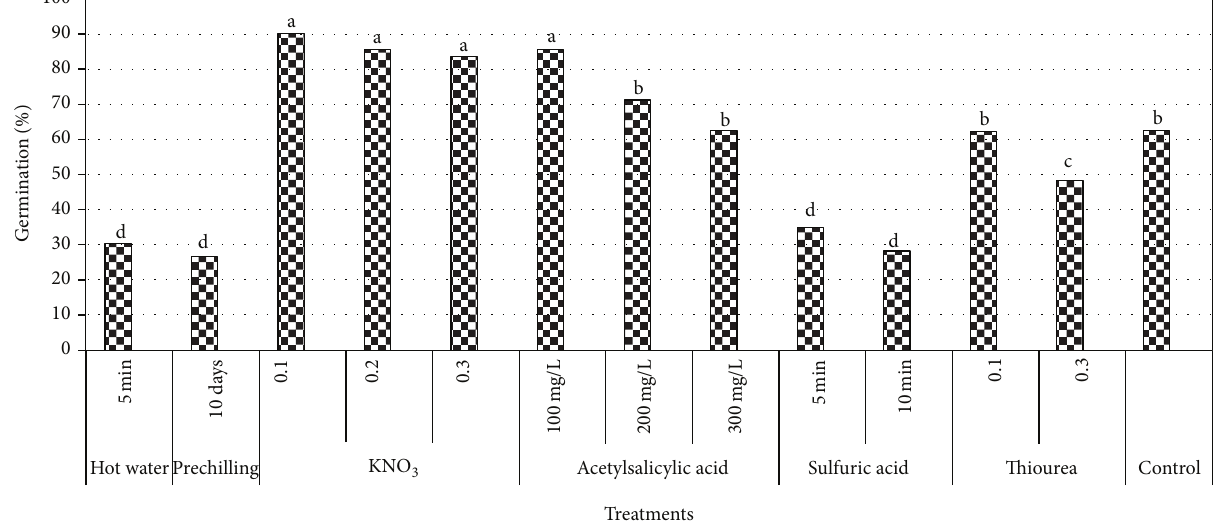
Figure 1: Comparison effects of various treatments on germination percentage of C. persica .